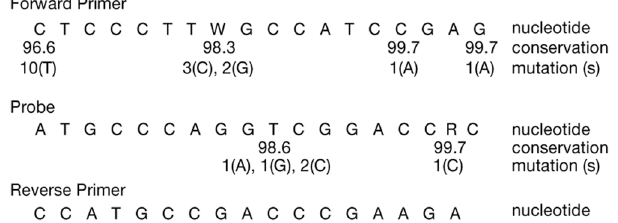
Figure 1. Diversity of primers and probe binding region. Complete HDV genome sequences (n = 291) were aligned using MUSCLE. Shown are primers (W = A, T) and probe (R = A, G) sequences. The percent conservation is indicated for nucleotide positions with mutation, along with the corresponding number of sequences with the indicated mutation. Where no number is listed, the conservation is 100% at the nucleotide